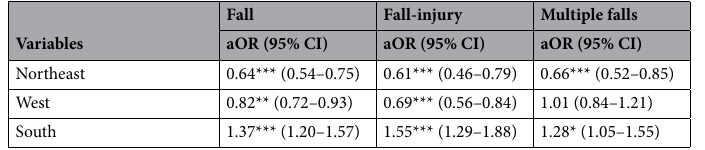
Table 3. Multivariable logistic regression estimates of fall, fall-injury and multiple falls by socioeconomic and health characteristics among older adults. Notes: *if p -value < 0.05, ** if p -value < 0.005, *** if p -value < 0.001; aOR: adjusted Odds Ratio; ADL: Activities of daily living; IADL: Instrumental activities of daily living; MPCE: Monthly per capita consumption expenditure.